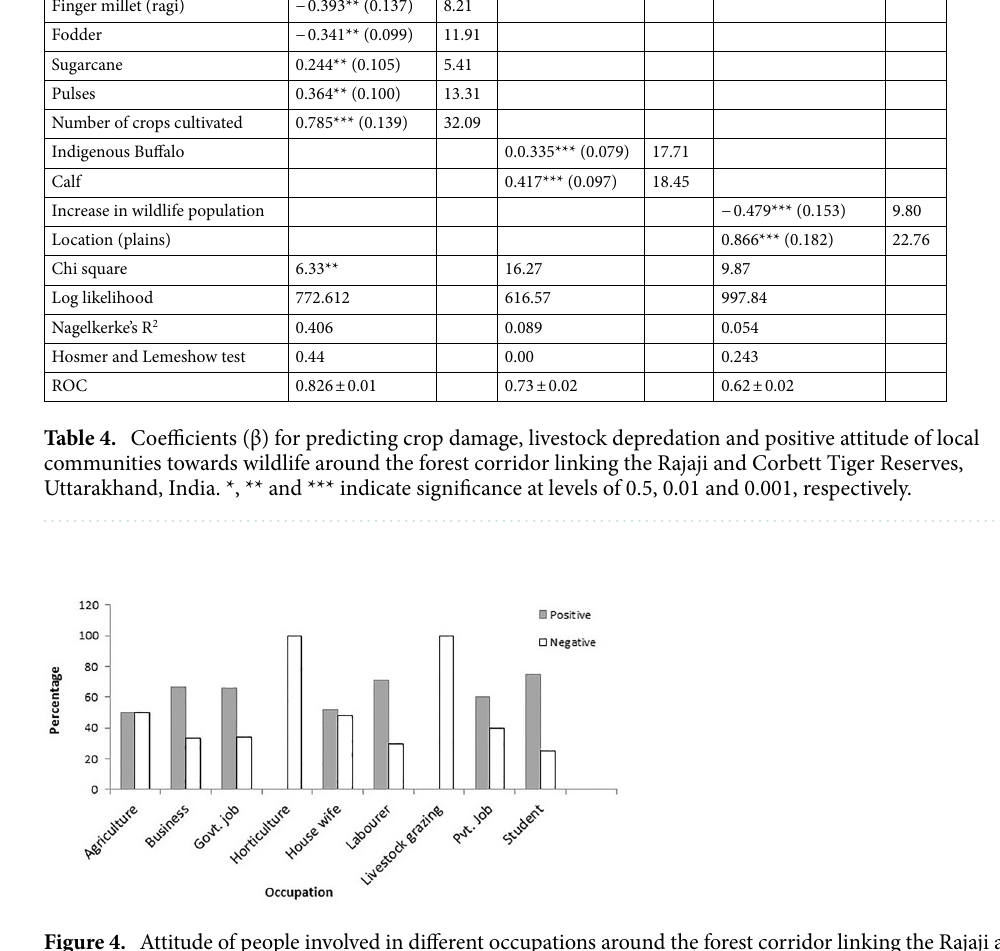
Figure 4. Attitude of people involved in different occupations around the forest corridor linking the Rajaji and Corbett Tiger Reserves, Uttarakhand, India.